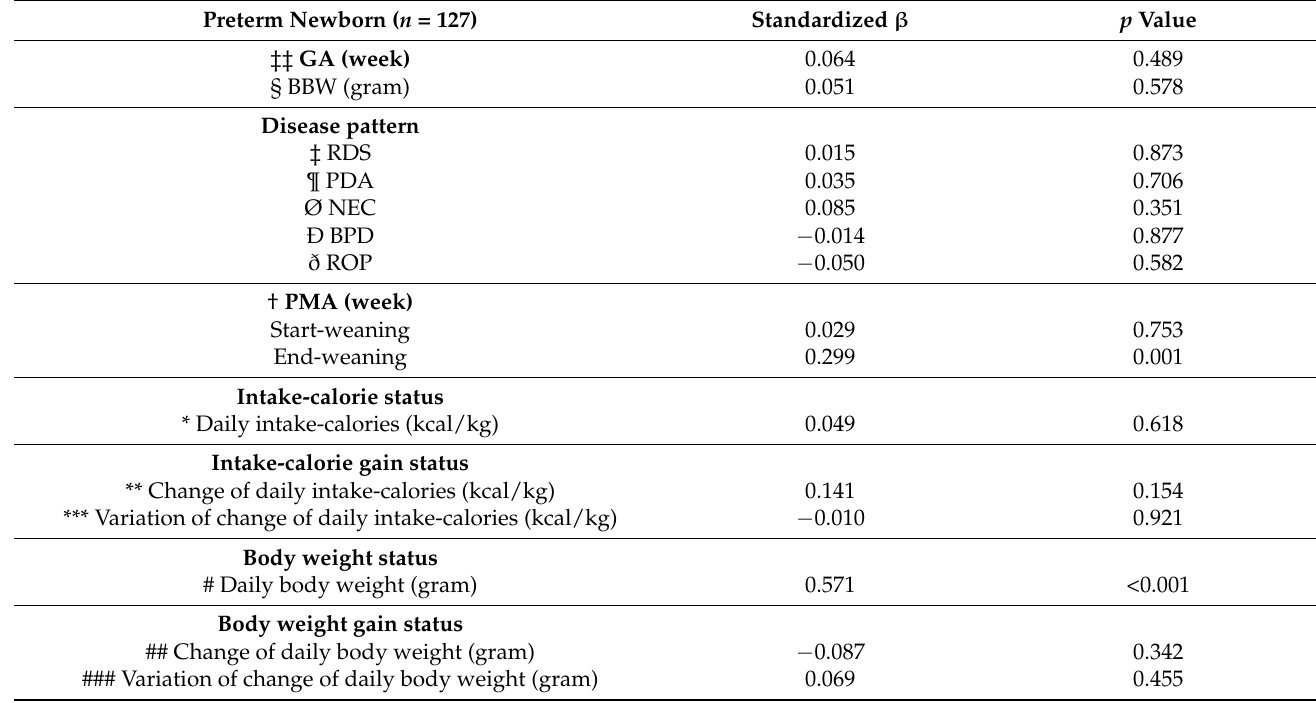
Table 3. Correlation of GA, BBW, and clinical characteristics with the weaning periods of the preterm newborns enrolled in the NICU of Kaohsiung Medical University Hospital by means of univariate linear regression.